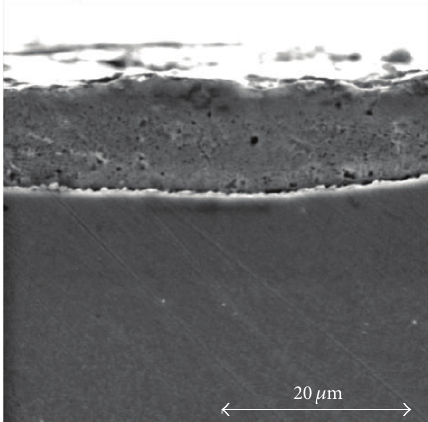
Figure 2: Test specimens for T-peel strength.